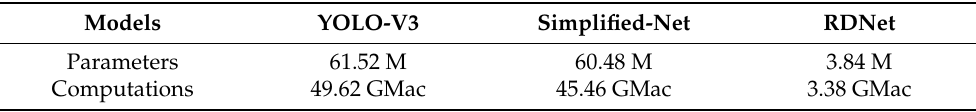
Table 3. Comparison between YOLO-V3, Simplified-Net and RDNet.